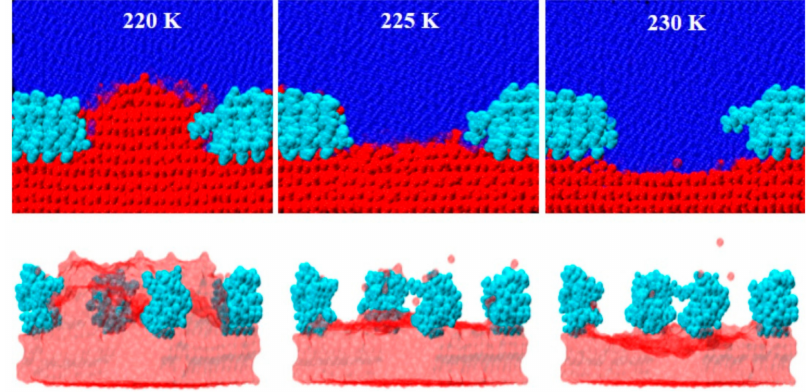
Figure 4. Atomistic molecular dynamics simulations on Tm AFP show inhibition of ice growth and melting below and above the equilibrium melting temperature, respectively, through the formation of convex and concave ice-water interfaces. Reprinted (adapted) with permission from Midya, U.S.; Bandyopadhyay, S. Operation of Kelvin E ff ect in the Activities of an Antifreeze Protein: A Molecular Dynamics Simulation Study. J. Phys. Chem . 2018 , 122 , 3079–3087. Copyright (2018) American Chemical Society